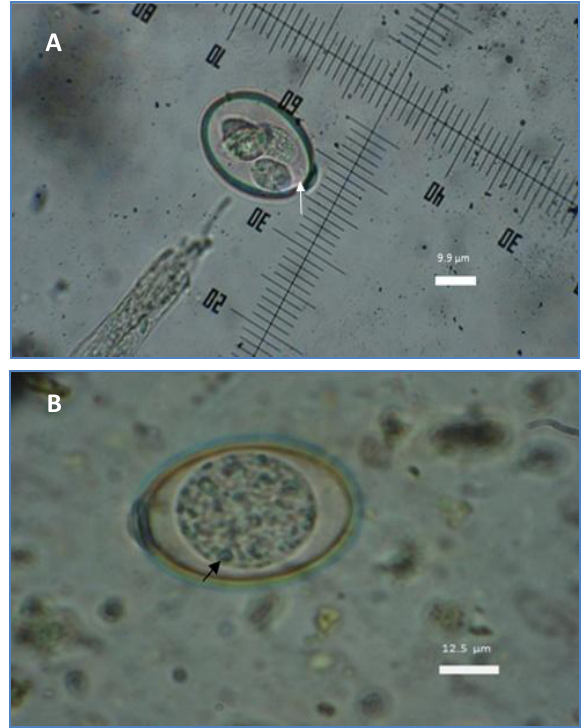
Figure, 2: Eimeria christenseni , oval Oocyst with micropyle (white arrow) and cup (A) with four elongated sporocysts in full sporulated Oocyst and the germinal disk (black arrow) clear (B) with outer and inner layer by saturated salt solution (X100).